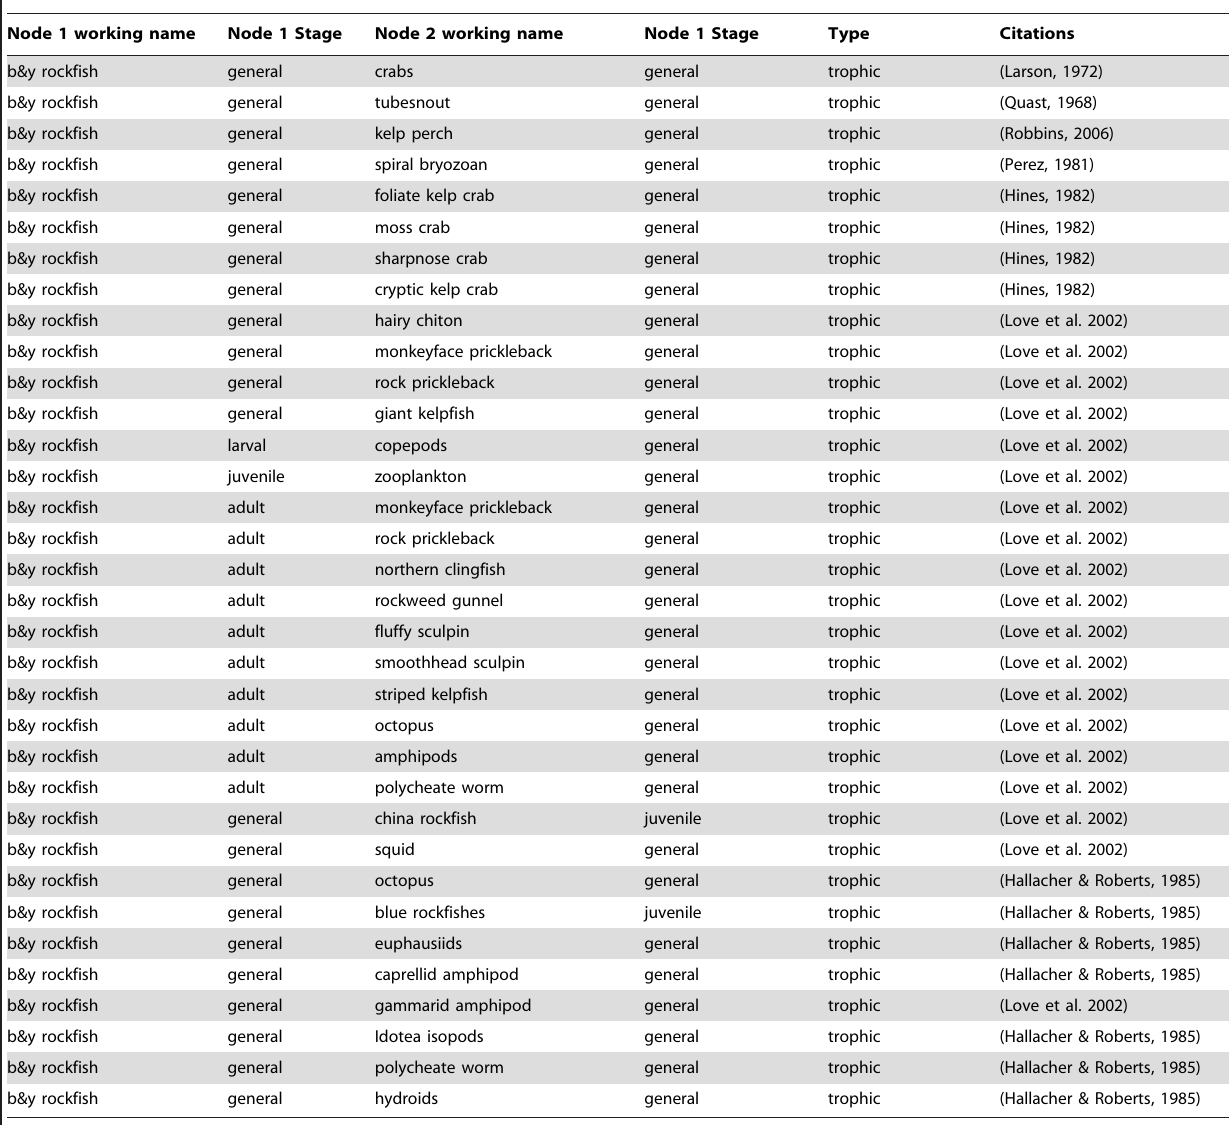
Table 3. Example of a csv file exported from the